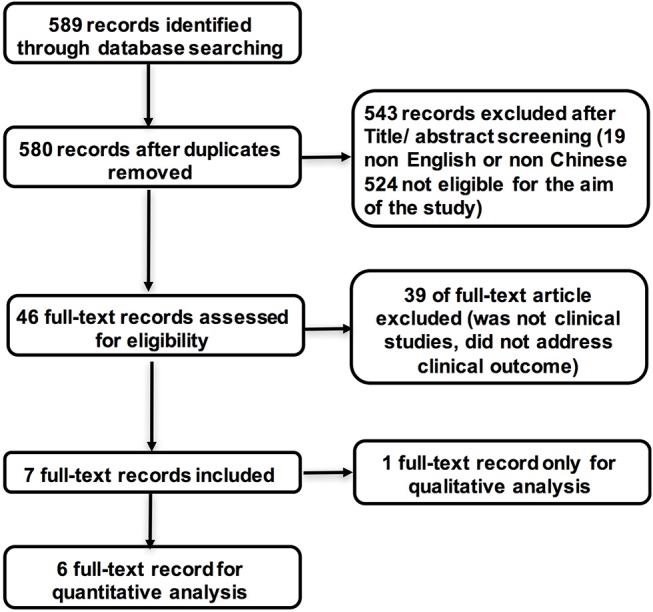
Flow chart of the study selection process.